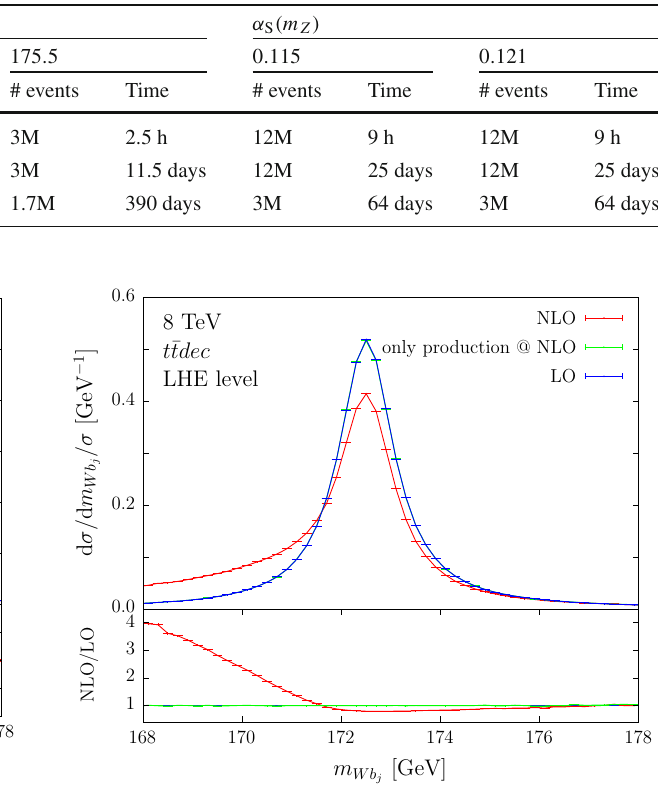
Fig. 1 d σ/ dm Wb distribution at LO (blue) and at NLO (red) obtained j with the h v q generator, normalized to 1 in the displayed range. In the bottom panel the ratio with the LO prediction is shown